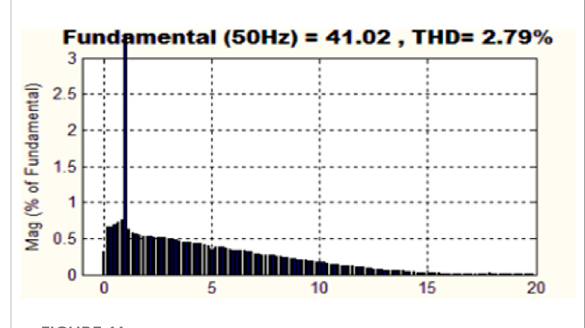
FIGURE 11 Source current THD using the ChNN